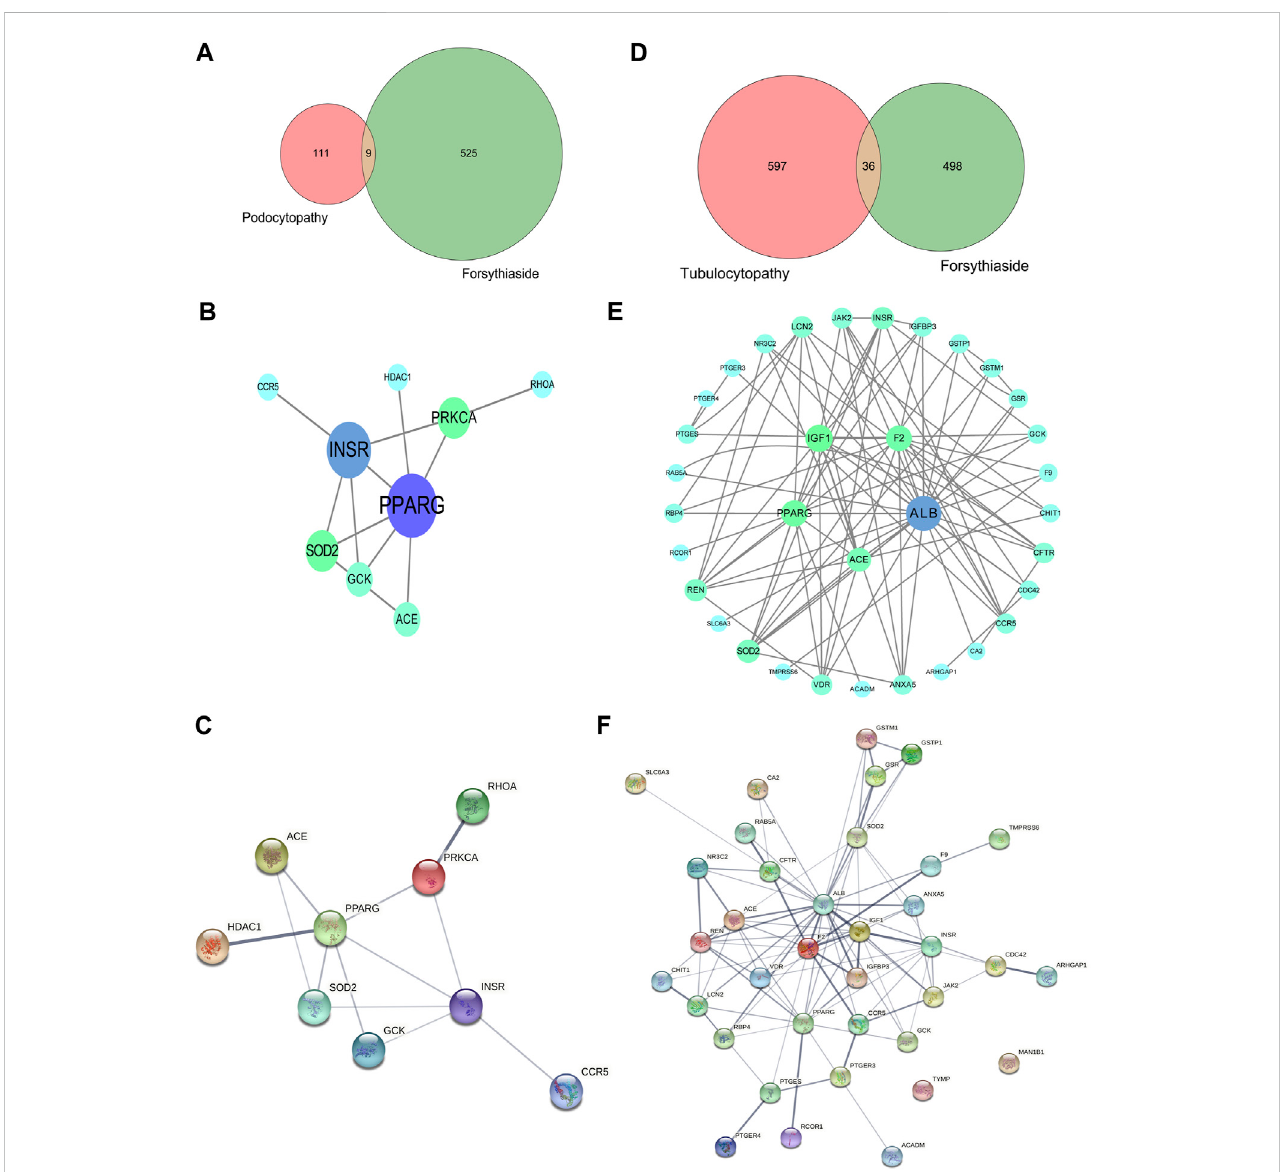
FIGURE 5 VenndiagramandPPInetworkofForsythiaside-diseasetargets. (A) VenndiagramofoverlappingtargetsofForsythiasideanddiabeticpodocytopathy. (B) PPI network of Forsythiaside-diabetic podocytopathy targets. Nine overlapping targets were presented as circle and ordered by the degree level. (C) The PPI network which re fl ected the interaction between nine overlapping targets was displayed by STRING website. (D) Venn diagram of overlapping targets of Forsythiaside and diabetic tubulopathy. (E) PPI network of Forsythiaside-diabetic tubulopathy targets. Thirty-six overlapping targets were presented as circleand orderedbythedegree level.Fivegeneswereofsigni fi cance inthenetwork,includingALB,PPARG,IGF1,F2andACE. (F) The PPInetwork analysis of 36 overlapping targets between Forsythiaside and diabetic tubulopathy was performed by STRING